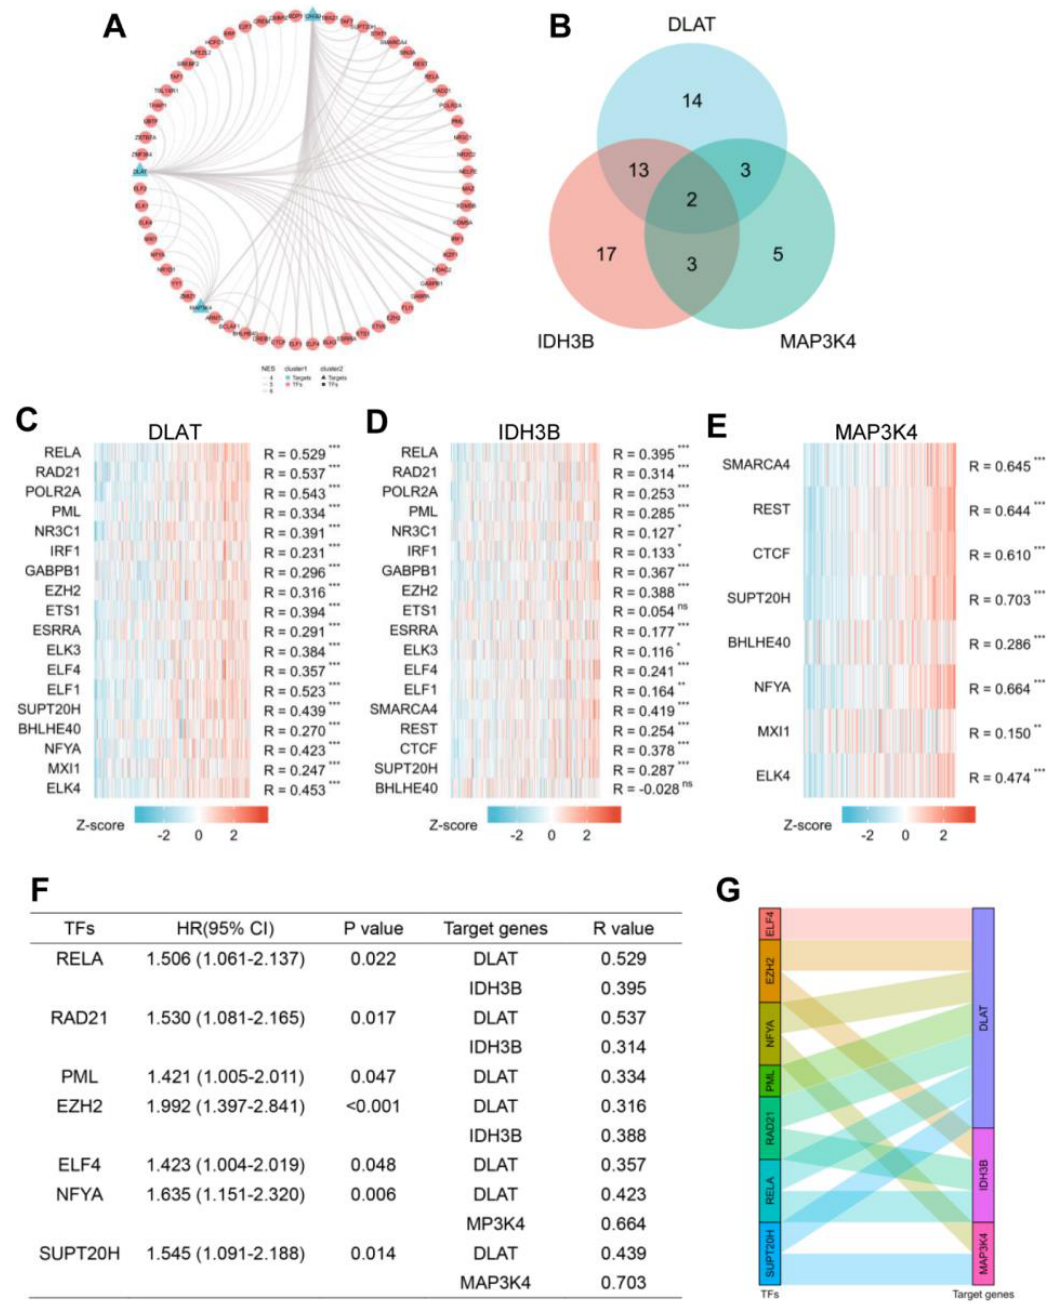
Figure 7. Prediction of potential TF-gene interactions. ( A ) The transcriptional network for DLAT, IDH3B, and MAP3K4. ( B ) Screening for TFs regulating at least 2 genes. ( C – E ) The heatmaps of correlations between predicted TFs and target genes. ( F ) Prognostic analysis of TFs with spearman R > 0.3. ( G ) The Sankey diagram showed the corresponding relationships between TFs and target genes. * p < 0.05, ** p < 0.01, *** p < 0.001 and ns, no significance.